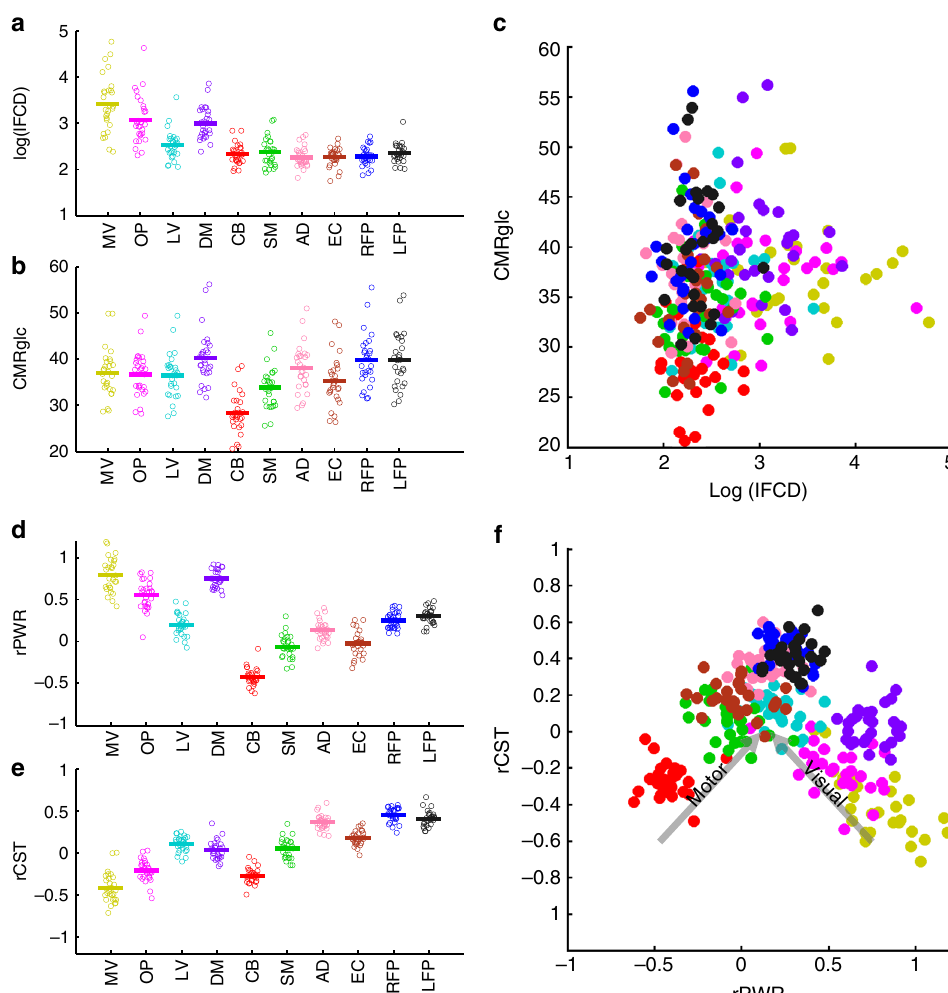
Fig. 2 Local functional connectivity density (lFCD), cerebral metabolic rate of glucose (CMRglc), relative power (rPWR), and relative cost (rCST) of brain networks and individual differences (cohort-1, n = 28). a , b Within-subject averages (28 circles) and between-subject average (thick line) of lFCD and CMRglc for each of 10 resting-state networks 33 including medial visual (MV), occipital pole (OP), lateral visual (LV), default mode (DM), cerebellum (CB), sensorimotor (SM), auditory (AD), executive control (EC), right and left frontoparietal (RFP and LFP) networks. c Within-subject averages of lFCD and CMRglc plotted against each other (each circle represents one participant) for the networks shown in a , b . The network colors in c match those shown in a , b . d , e Within-subject averages (28 circles for 28 participants) and between-subject average (thick lines) of rPWR and rCST for each of the 10 resting- state networks shown in parts a , b . f Within-subject averages of rPWR and rCST plotted against each other for the networks shown in d , e . The network colors in f match those shown in d ,